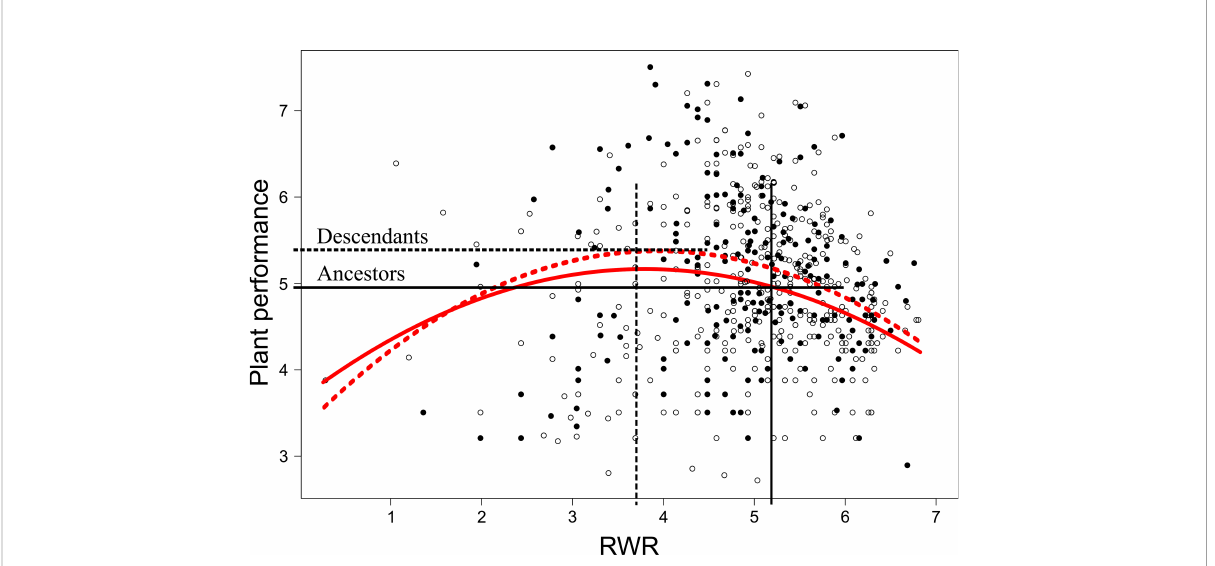
FIGURE 4 Non-linear selection gradients on root weight ratio (RWR) for ancestors and descendants in the less predictable early treatment. Solid and dashed red lines represent ancestors and descendants selection gradients, respectively. White and black dots represent data of ancestors and descendants, respectively. Average RWR of ancestors and descendants exposed to the less predictable early treatment (see Figure 3B) are indicated with vertical black lines and differences in plant performance between ancestors and descendants are indicated with horizontal black